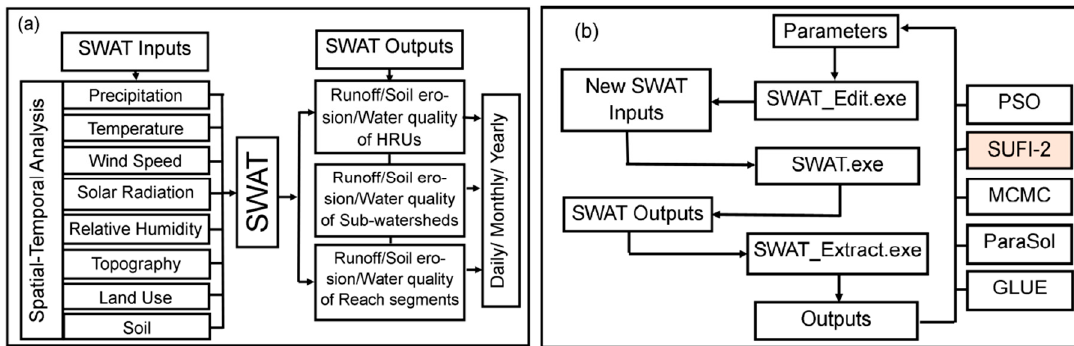
Figure 3. ( a ) Schematic overview of the Soil and Water Assessment Tool (SWAT) model; ( b ) the relationship between the Soil and Water Assessment Tool—Calibration and Uncertainty Procedures (SWAT—CUP) and its five optimization algorithms. HRU: hydrological response unit; SUFI-2, Sequential Uncertainty Fitting version 2; PSO: particle swarm optimization; MCMC: Markov chain Monte Carlo; GLUE: generalized likelihood uncertainty estimation.